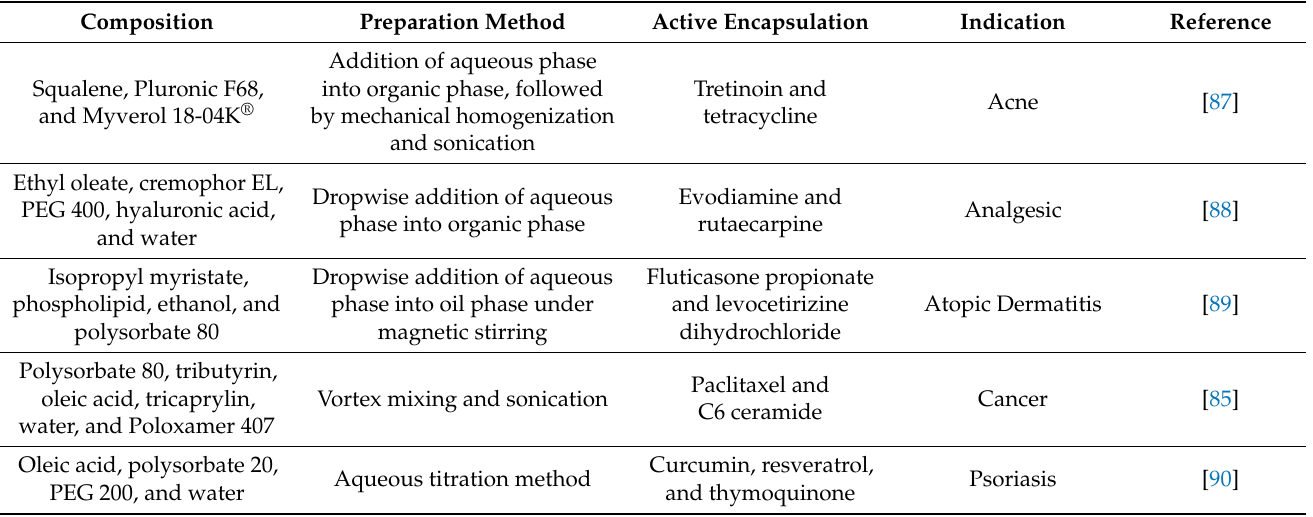
Table 4. Examples of micro- and nanoemulsions and the diseases that can benefit from co- encapsulated